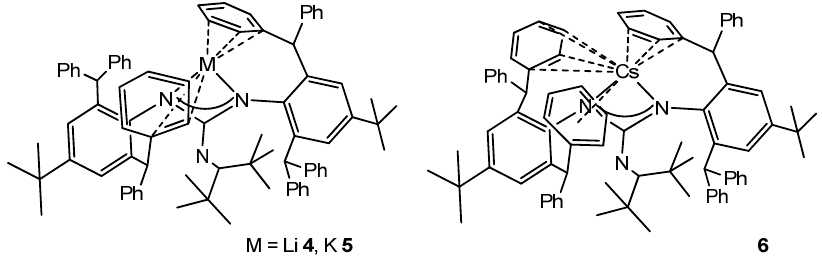
Figure 5. Alkali metal complexes exhibiting bond interactions with the aromatic substituents of the guanidinato ligands.